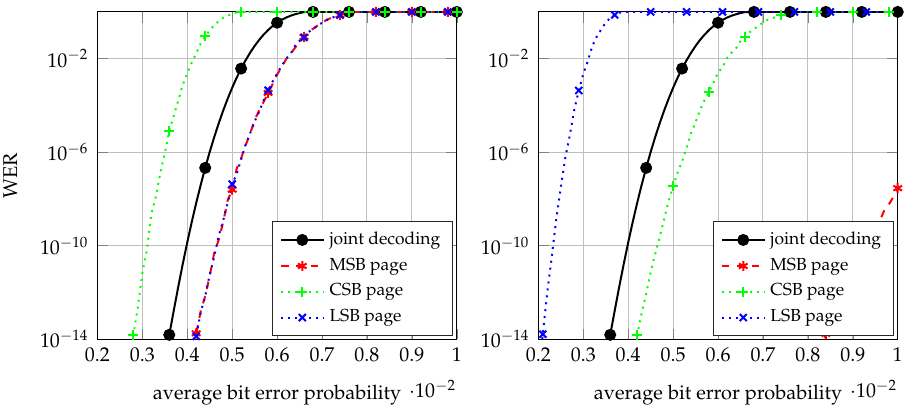
Figure 6. GC codes of rate R = 0.9 and 4 kB of payload data for a TLC model using Gray code 1 ( left ) and Gray code 2 ( right